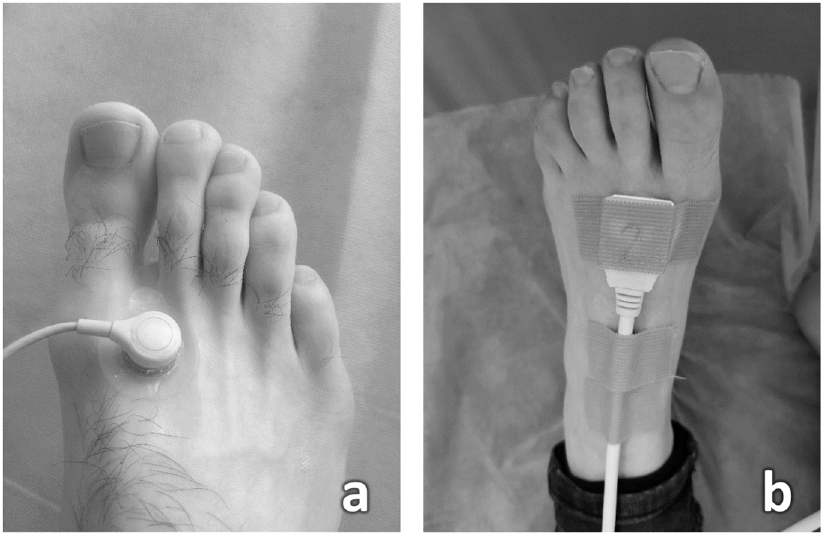
Figure 1. ( a ) TcpO 2 measurement procedure; ( b ) procedure for measuring perfusion using the IOFF method .